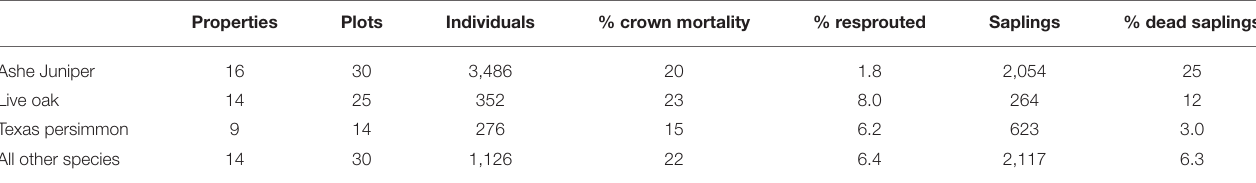
TABLE 1 | Occurrence, abundance, and health status of taxa selected for analysis. Properties Plots